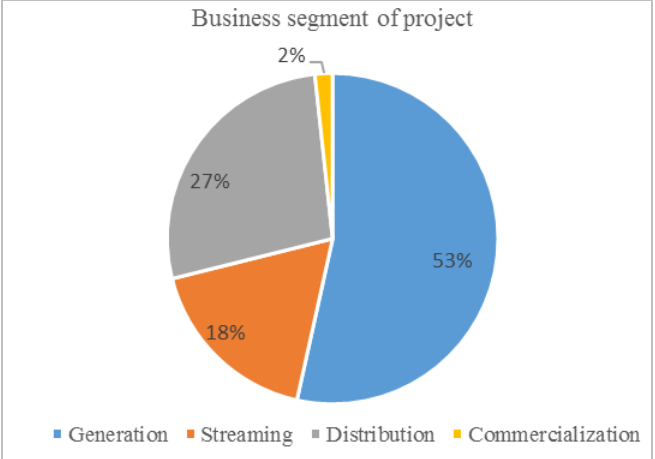
Fig. 1. Percentage by Bussiness Scope of Project (ANEEL, march